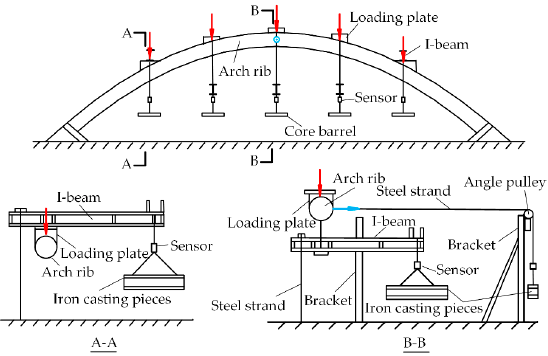
Figure 1. The experimental apparatus of the arch.